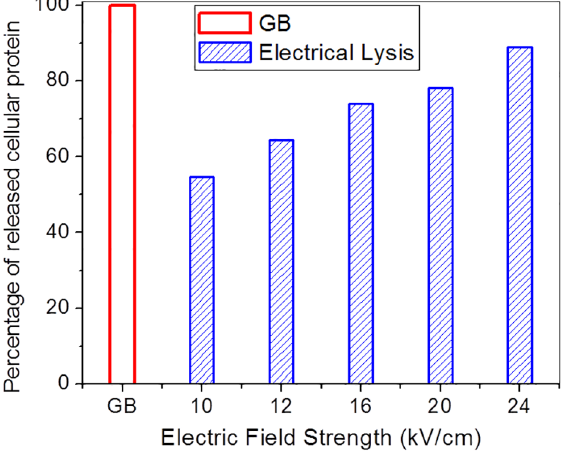
Figure 11. The lysis efficiency of S.pneumoniae as a function of electric field strength. The lysis efficiency of S. pneumoniae cells subjected to electrical lysis which combined electric field with flash heating to 100 u C was determined by measuring the released protein. The amount of released protein is reported as a percentage of protein released by glass bead